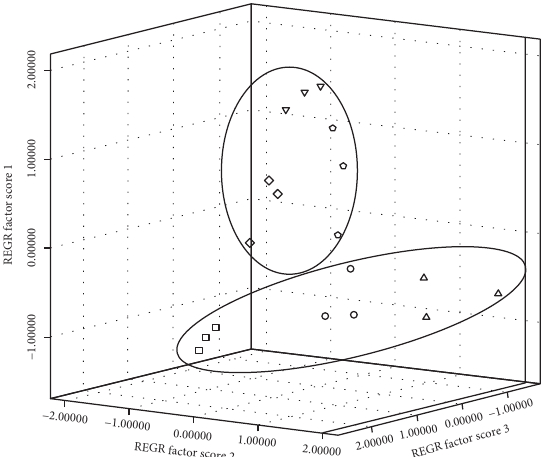
Figure 3: Score distribution of principal component analysis.